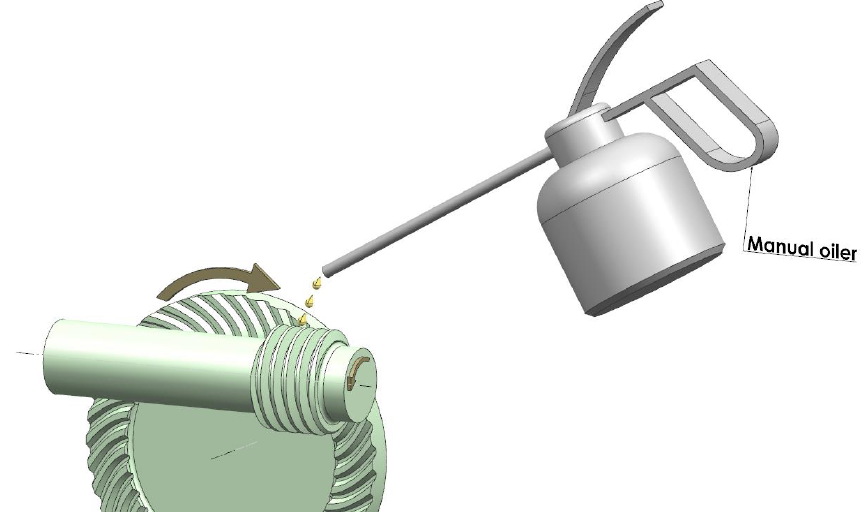
Figure 5. Intermittent lubrication of open gear, manual lubrication method.